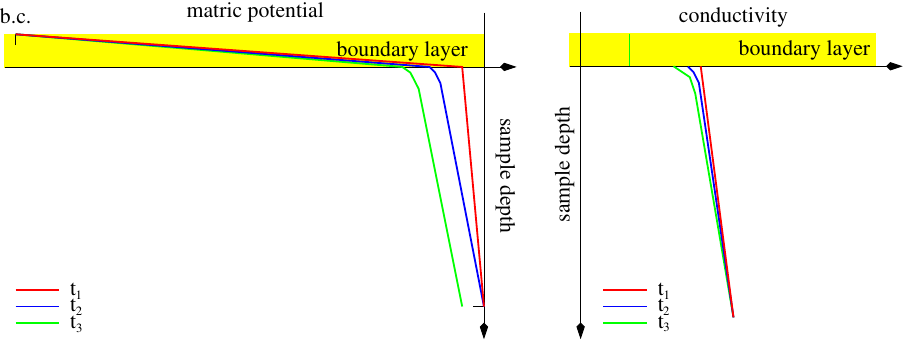
Fig. 3. Sketch of the potential (left) and conductivity (right) development in regime I.